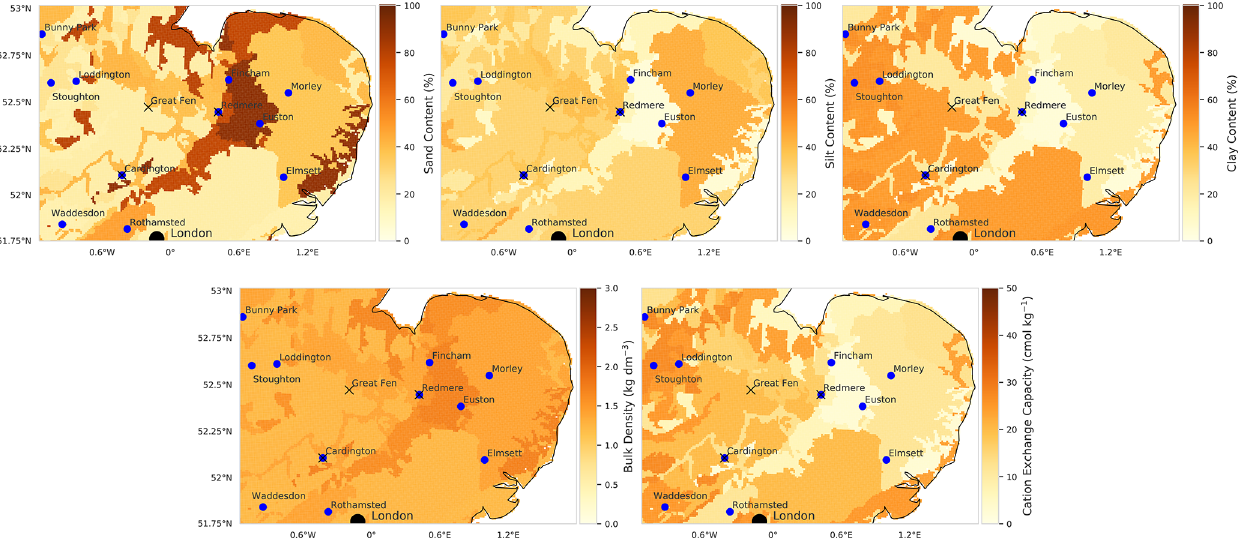
Figure 1. Maps of soil properties from the Harmonised World Soil Database (HWSD) (Fischer et al., 2008) used in the creation of the JULES soil parameter ancillaries with the Tóth et al. (2015) pedotransfer functions. Blue dots show locations of COSMOS-UK probes, crosses show flux tower locations and the black dot shows the location of London,